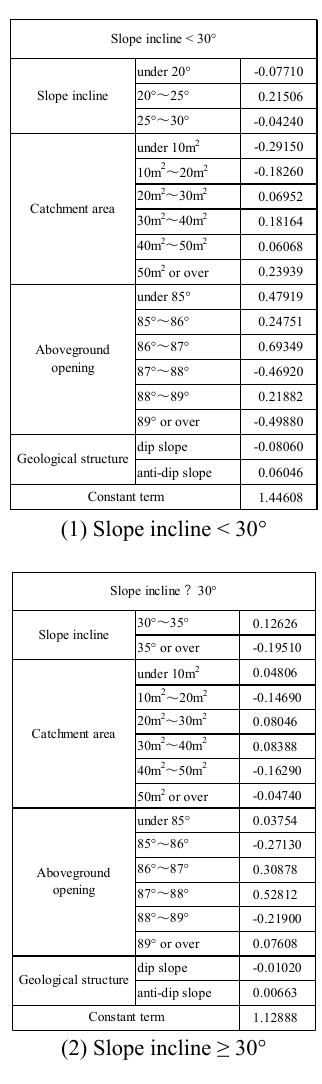
Table 1. Topsoil thickness equation parameters